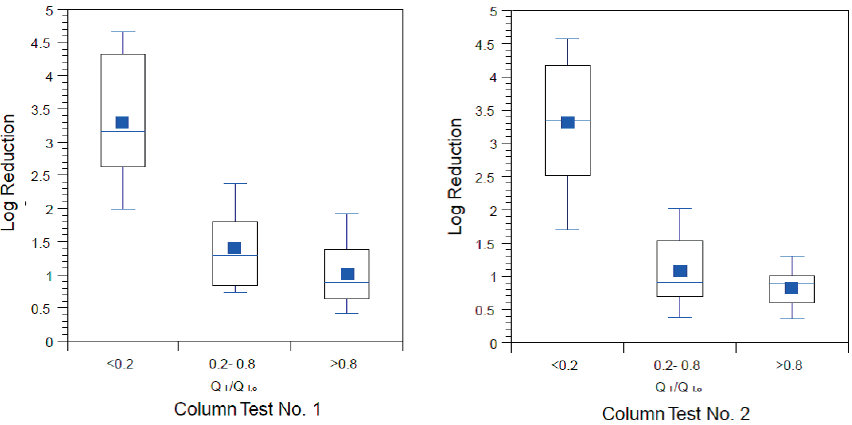
Figure 8. E. coli reductions in Column Test No. 1 and Column Test No. 2 organized by bins of normalized filtration rate where Q I is the initial daily filtration rate on each day of charging the column and Q I,o is the comparable initial filtration rate on the first day. N for Column Test No. 1: 14 for <0.2, 13 for 0.2–0.8, 23 for >0.8. N for Column Test No. 2: 15 for <0.2, 34 for 0.2–0.8, 30 for